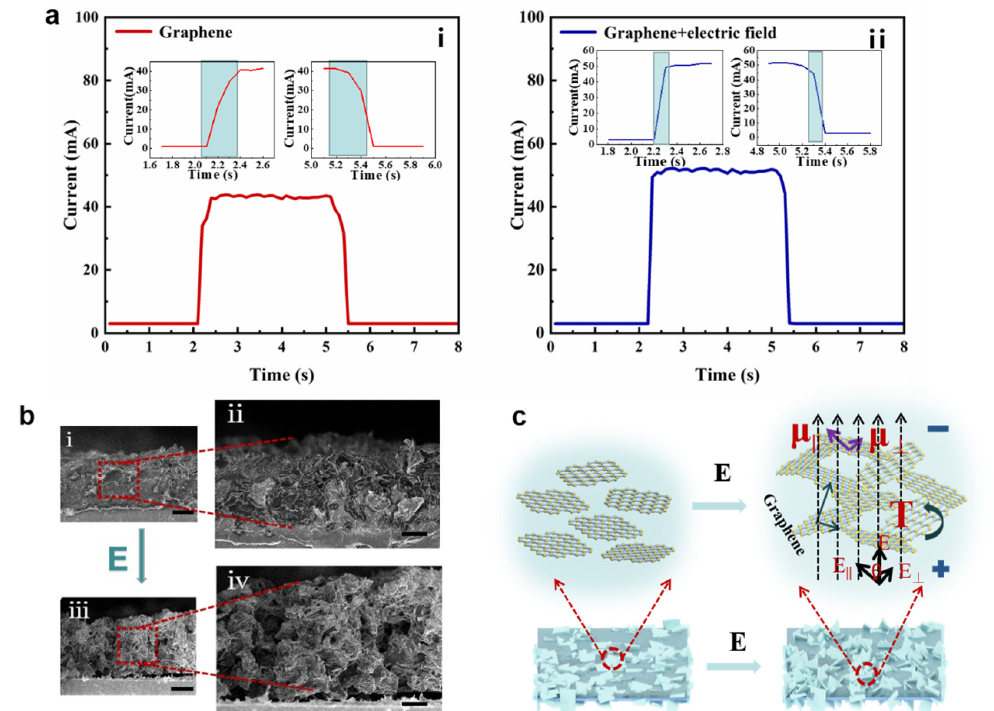
Figure 2. ( a ) Response/recovery time of the sensor at 50 kPa before and after electric field induction. ( ai ) is the response and response time of the unapplied electric field, ( aii ) is the response and re ‐ ( a ( i )) is the response and response time of the unapplied electric field, ( a ( ii )) is the response and sponse time of the applied electric field. ( b ) The cross ‐ sectional morphology of the coating before response time of the applied electric field. ( b ) The cross-sectional morphology of the coating before and after the electric field induction: ( bi ,b ii ) are the cross ‐ sectional morphology before the electric and after the electric field induction: ( b ( i ), b ( ii )) are the cross-sectional morphology before the electric field induction; ( biii , biv ) are the cross ‐ sectional morphology of the coating after the electric field induction. ( bi , biii ) scale bar: 50 μ m; ( bii , biv ) scale bar: 25 μ m. ( c ) Schematic diagram of graphene field induction; ( b ( iii ), b ( iv )) are the cross-sectional morphology of the coating after the electric field nanosheets being twisted by force in an electric field. induction. ( b ( i ), b ( iii )) scale bar: 50 µ m; ( b ( ii ), b ( iv )) scale bar: 25 µ m. ( c ) Schematic diagram of graphene nanosheets being twisted by force in an electric